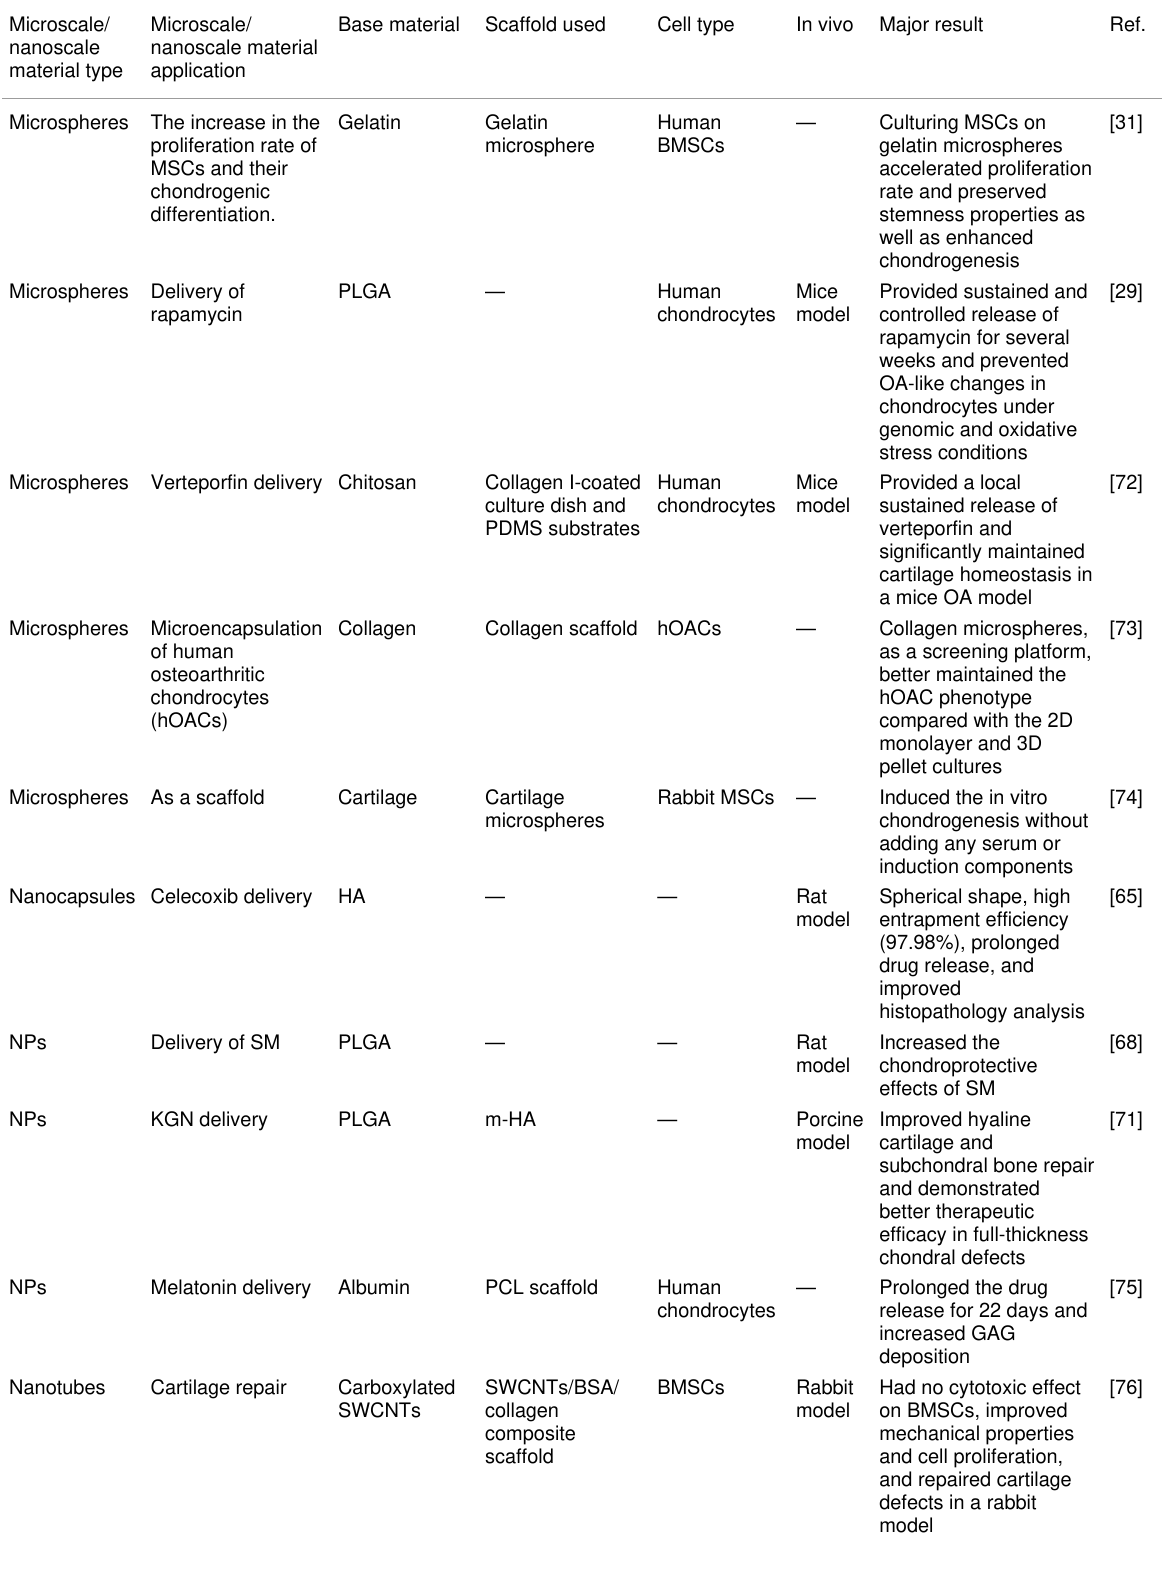
Table 1: Summary of the recent studies on microscale/nanoscale materials used for the fabrication of cartilage tissue engineering (TE) structures.